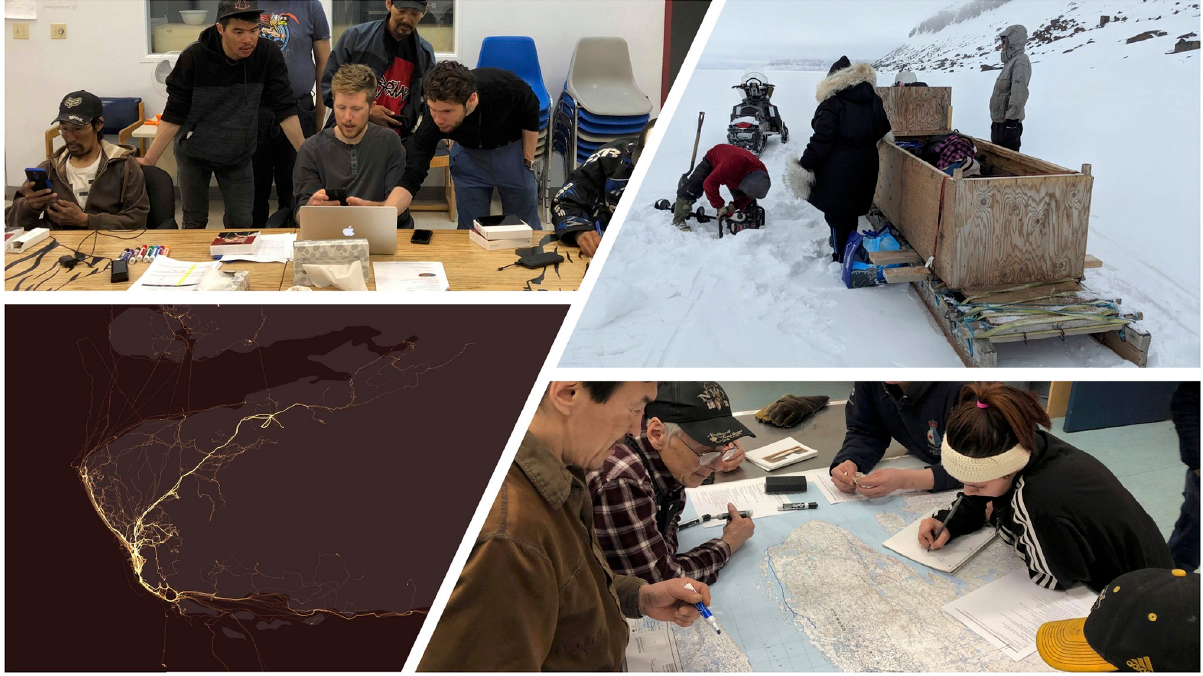
Fig 3. Types of elicitation and data analysis. a): real-time GPS tracking, import of data into QGIS 3.12 and ArcGIS 10.08, b) participant observation, c) participatory mapping and bi-weekly semi-structured/conversational interview. Basemap: Dark Grey Canvas (Attribution: Esri, HERE, Garmin, INCREMENT P, © OpenStreetMap contributors, and the GIS user